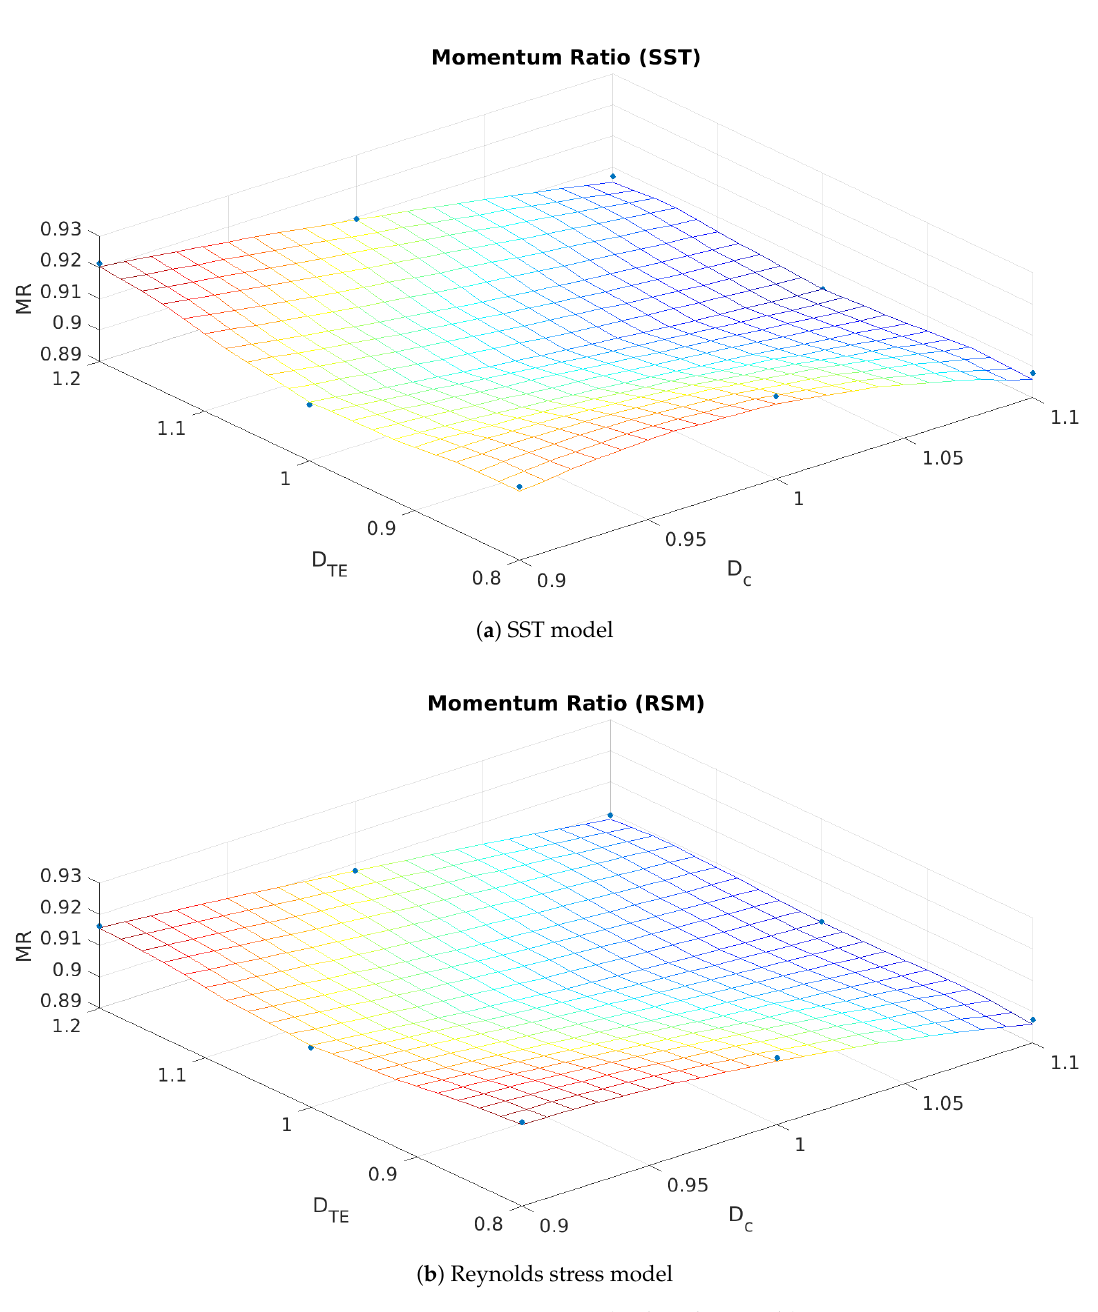
Figure 9. Momentum Ratio MR (Padè